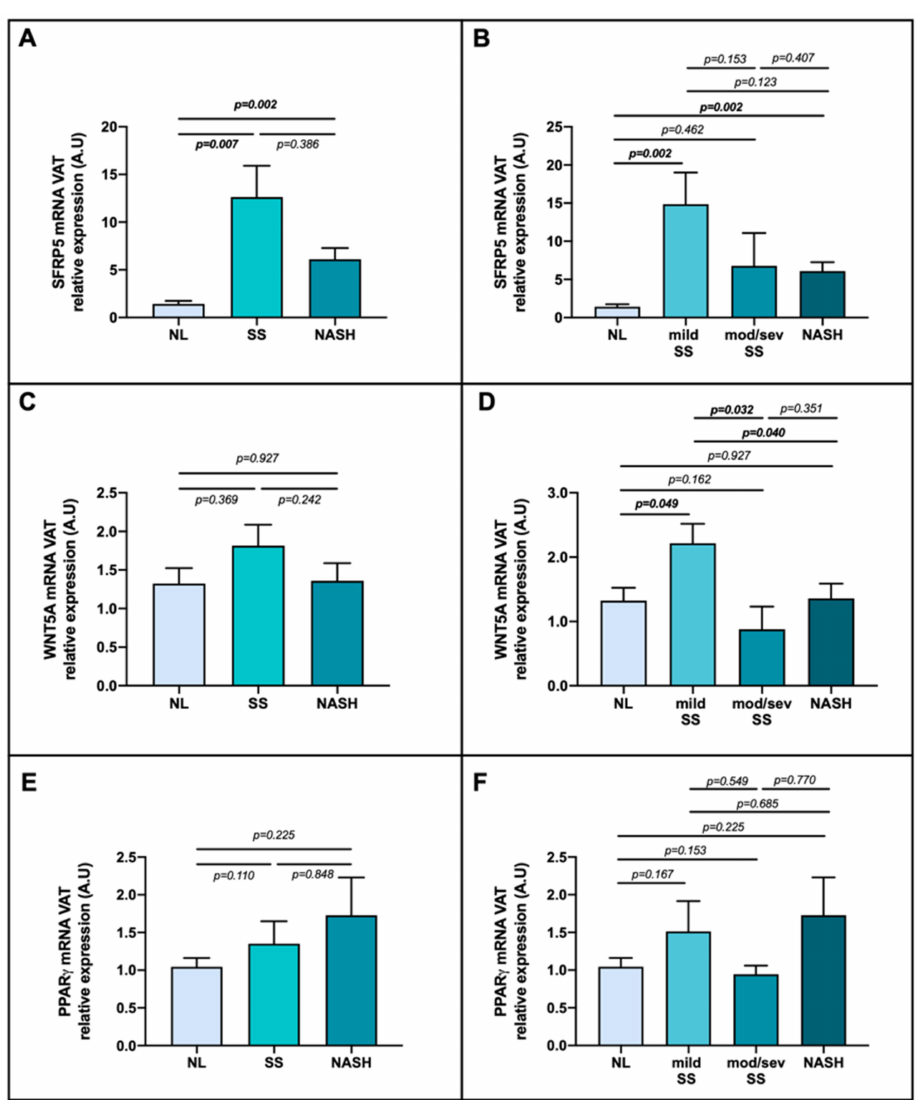
Figure 6. Differential relative mRNA abundance of ( A ) SFRP5, ( C ) WNT5A and ( E ) PPAR γ in visceral adipose tissue of women with MO classified by their liver histology as NL, SS and NASH; also, differential relative mRNA abundance of ( B ) SFRP5, ( D ) WNT5A and ( F ) PPAR γ classified as NL, mild SS, mod/sev SS, and NASH depending on the histopathological groups. The data were normalized by NL group and expressed as mean standard error of the mean (SEM). VAT, visceral adipose tissue; SFRP5, secreted frizzled-related protein 5; WNT5A, WNT family member 5a; PPAR γ , peroxisome proliferator-activated receptor gamma; MO, morbid obesity; SS, simple steatosis; mod/sev SS, moderate and severe SS; NASH, nonalcoholic steatohepatitis; A.U arbitrary units. p < 0.05 was considered statistically significant